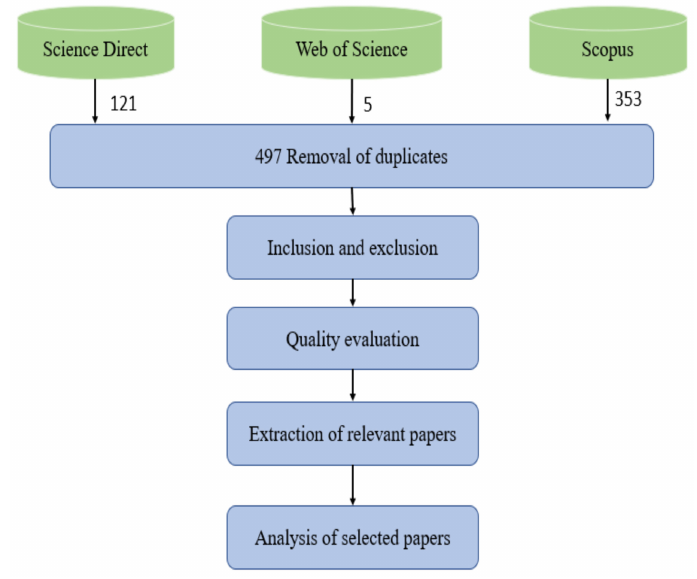
Figure 7. Methodology process